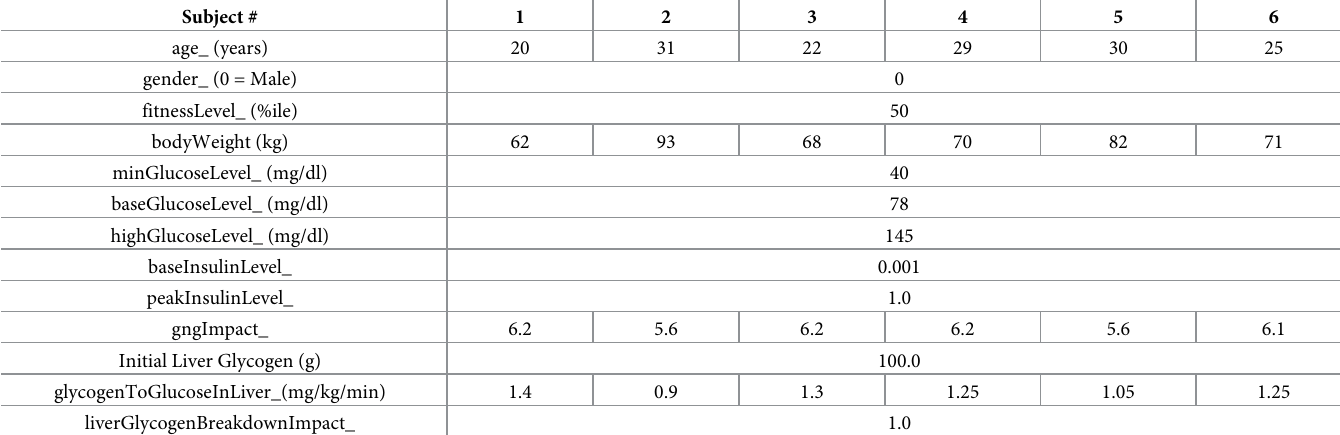
Table 10. Configuration parameters for simulations for a single “leg” exercise event at intensity 30% VO 2 max